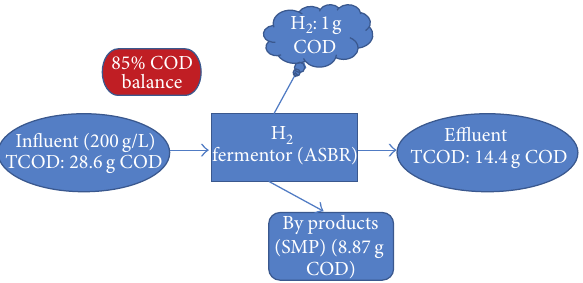
Figure 5: COD balance of the ASBR